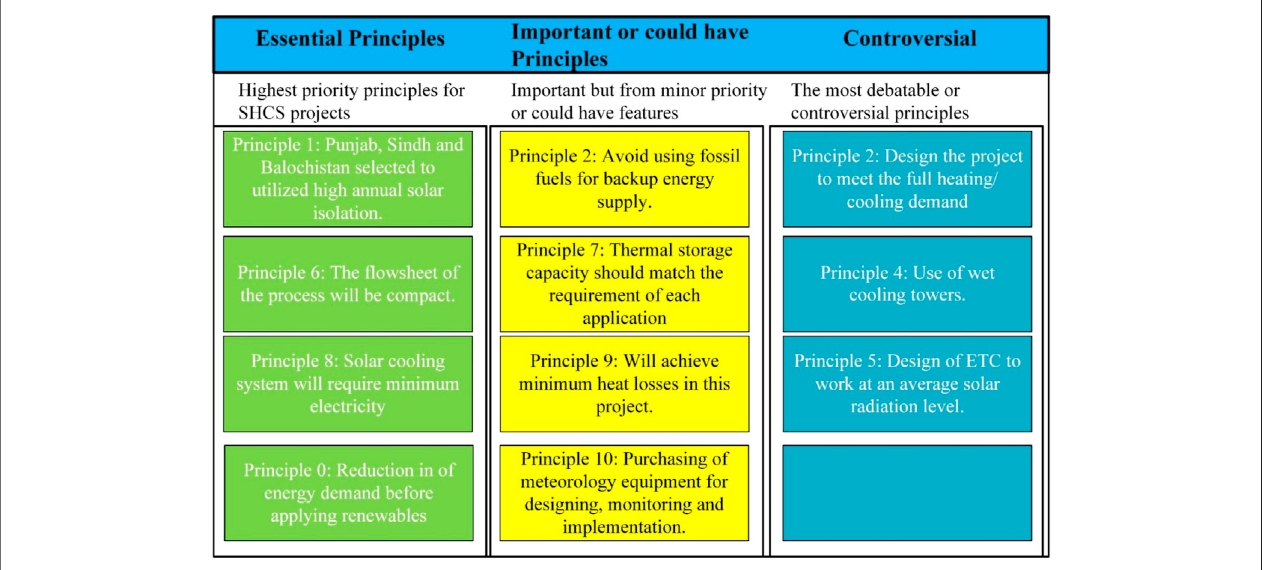
FIGURE 16 | Design criteria for MVP using three categories of 10 key principles.